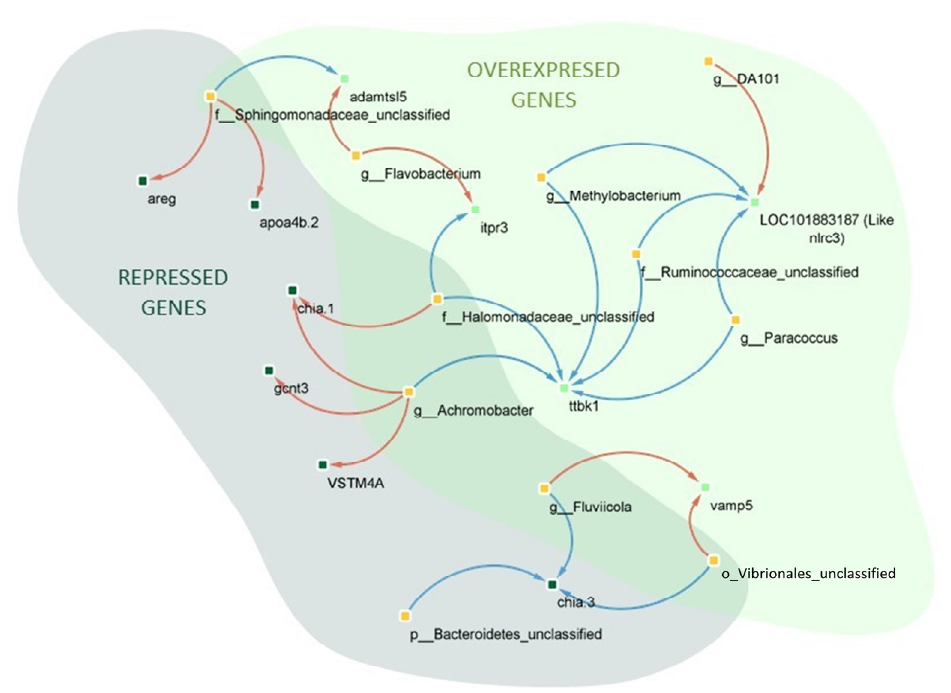
Figure 8. Correlation network gene (green nodes)—OTU (orange nodes) significant (Spearman, p < 0.05 and r < |0.9|, p < 0.05) based on DEG with the highest change value in the PW vs. CW comparison. Red lines indicate positive correlations while blue lines show negative correlations.